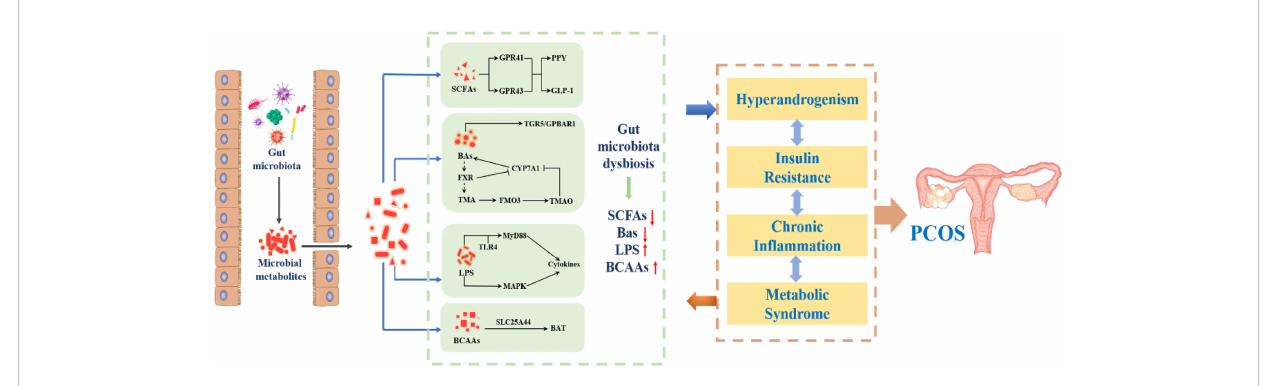
FIGURE 5 The internal relationship between intestinal fl ora and